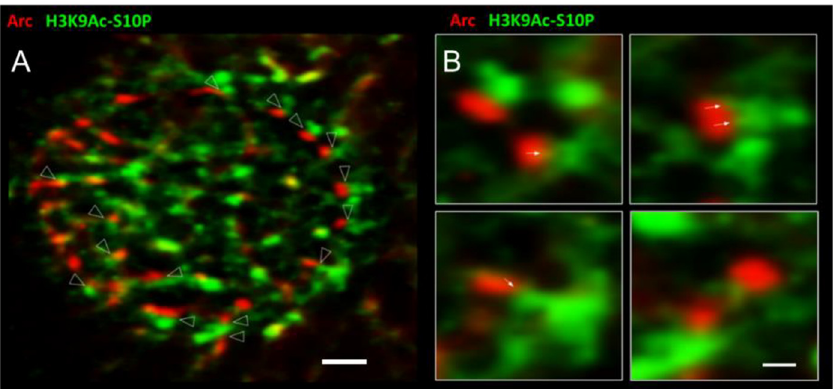
Figure 5. Arc associates with H3K9Ac-S10P. Image of a neuronal nucleus obtained using STORM. Cultured hippocampal neurons were treated with 4BF for 4 h, fixed and stained for Arc and H3K9Ac-S10P, which marks sites undergoing active transcription. ( A ) Arrowheads point to close appositions between Arc and the histone mark (scale bar = 1 µm). ( B ) Enlarged sections showing the association in greater detail. Arrows inside the Arc puncta point to what appear to be invasions of H 3K9Acc-S10P into Arc puncta (scale bar 200 nm). Regions of overlap appear in yellow.